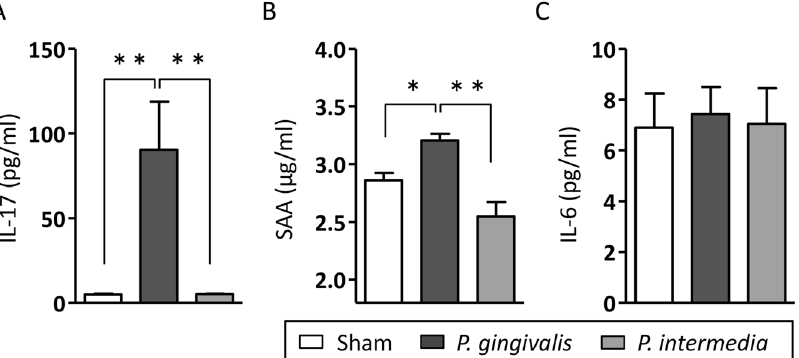
Figure 4. Effect of oral administration of P. gingivalis and P. intermedia on serum levels of inflammatory markers. Serum levels of IL-17 ( A ), serum amyloid A ( B ), and IL-6 ( C ) were compared between sham-, P. gingivalis -, and P. intermedia -administered mice. Data are expressed as the mean ± SEM (N = 6). * p < 0.05, ** p < 0.01, One-way ANOVA with Bonferroni corrections for multiple